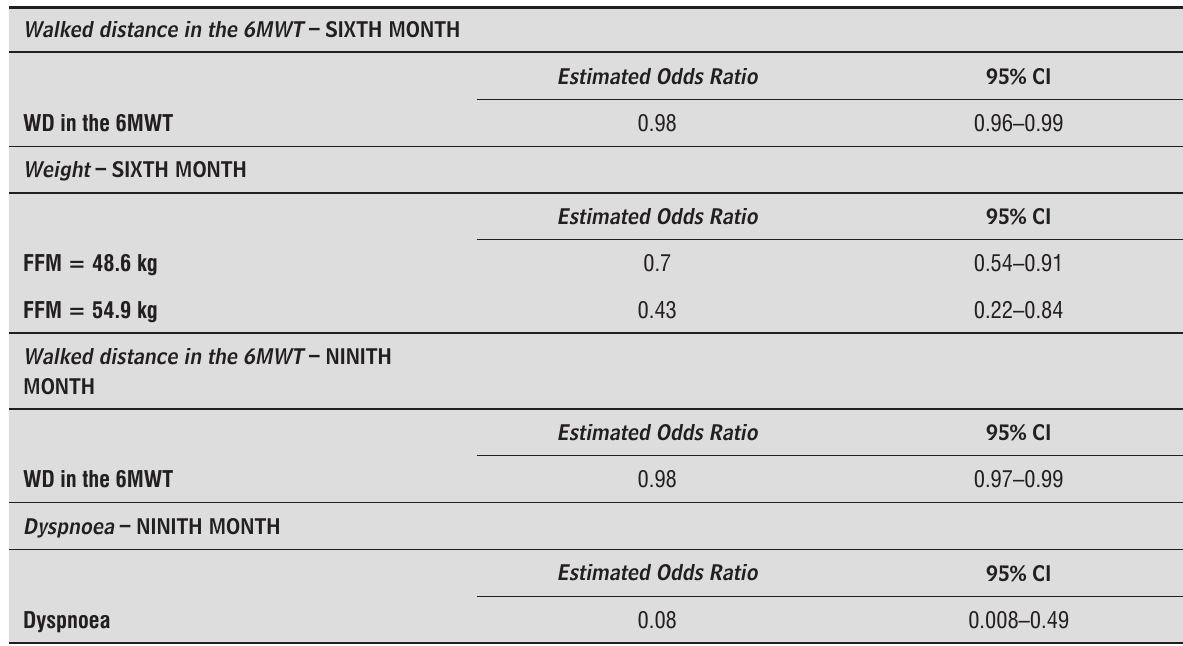
Table 4 - Walked distance in the 6MWT, and the interaction of the Fat-free mass with the body weight, presented in estimated odds ratio and its 95 % Confidence interval after six month follow-up; Walked distance in the 6MWT and dyspnoea after nine months of follow